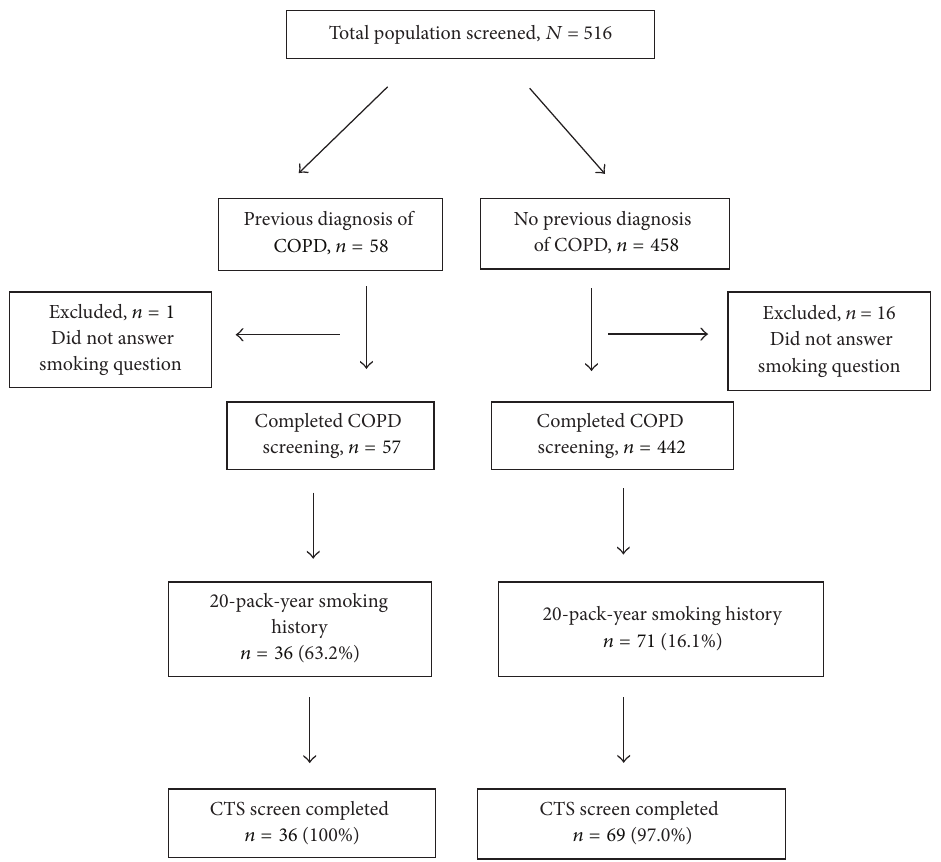
Figure 1: Response